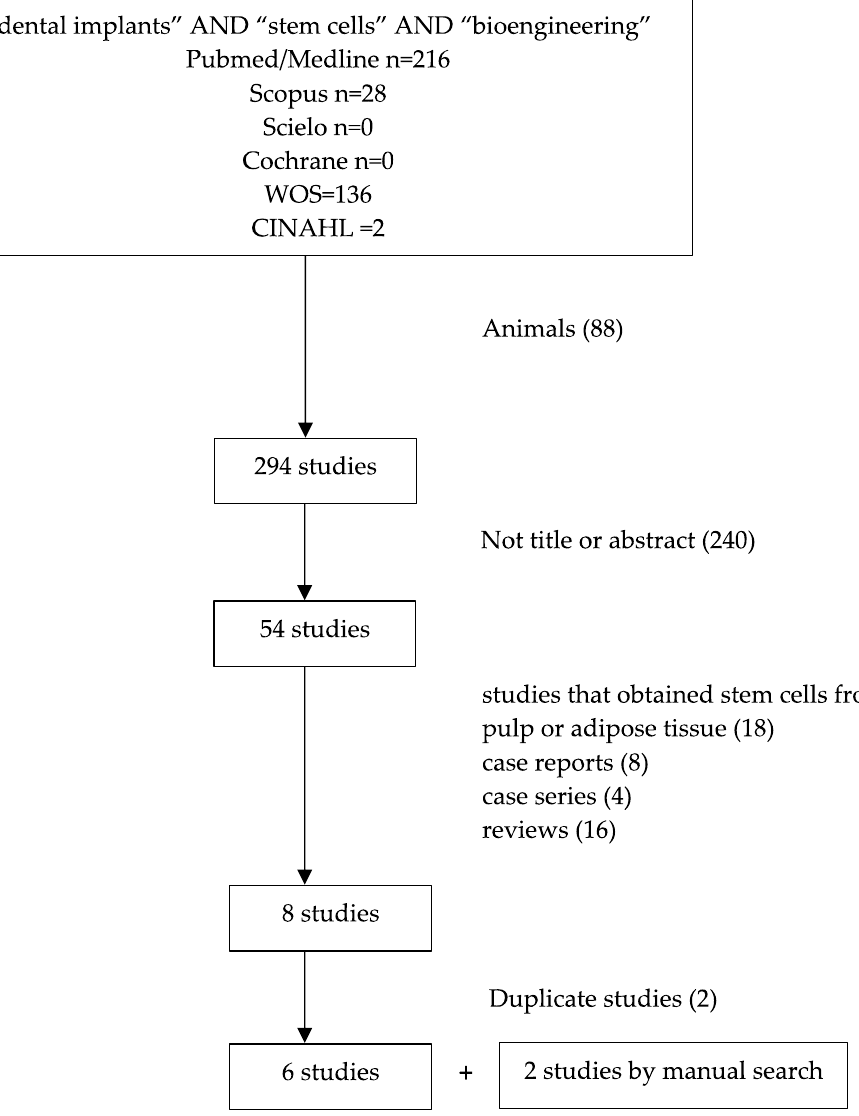
Figure 1. Flow chart illustrating the search strategy in the Pubmed/Medline database.